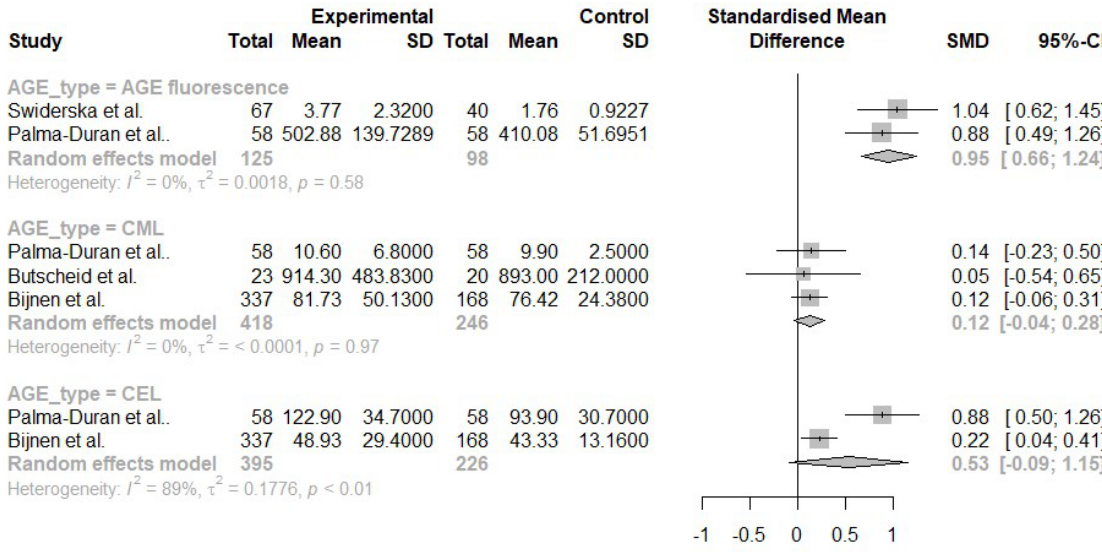
Figure 3. Pairwise comparisons of serum AGE levels between patients with NAFLD and healthy controls [30,32,34,36].